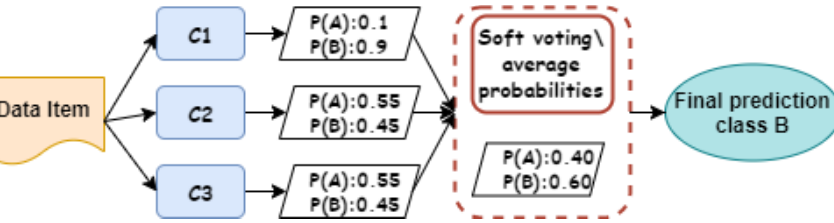
Figure 3. Soft ensemble voting